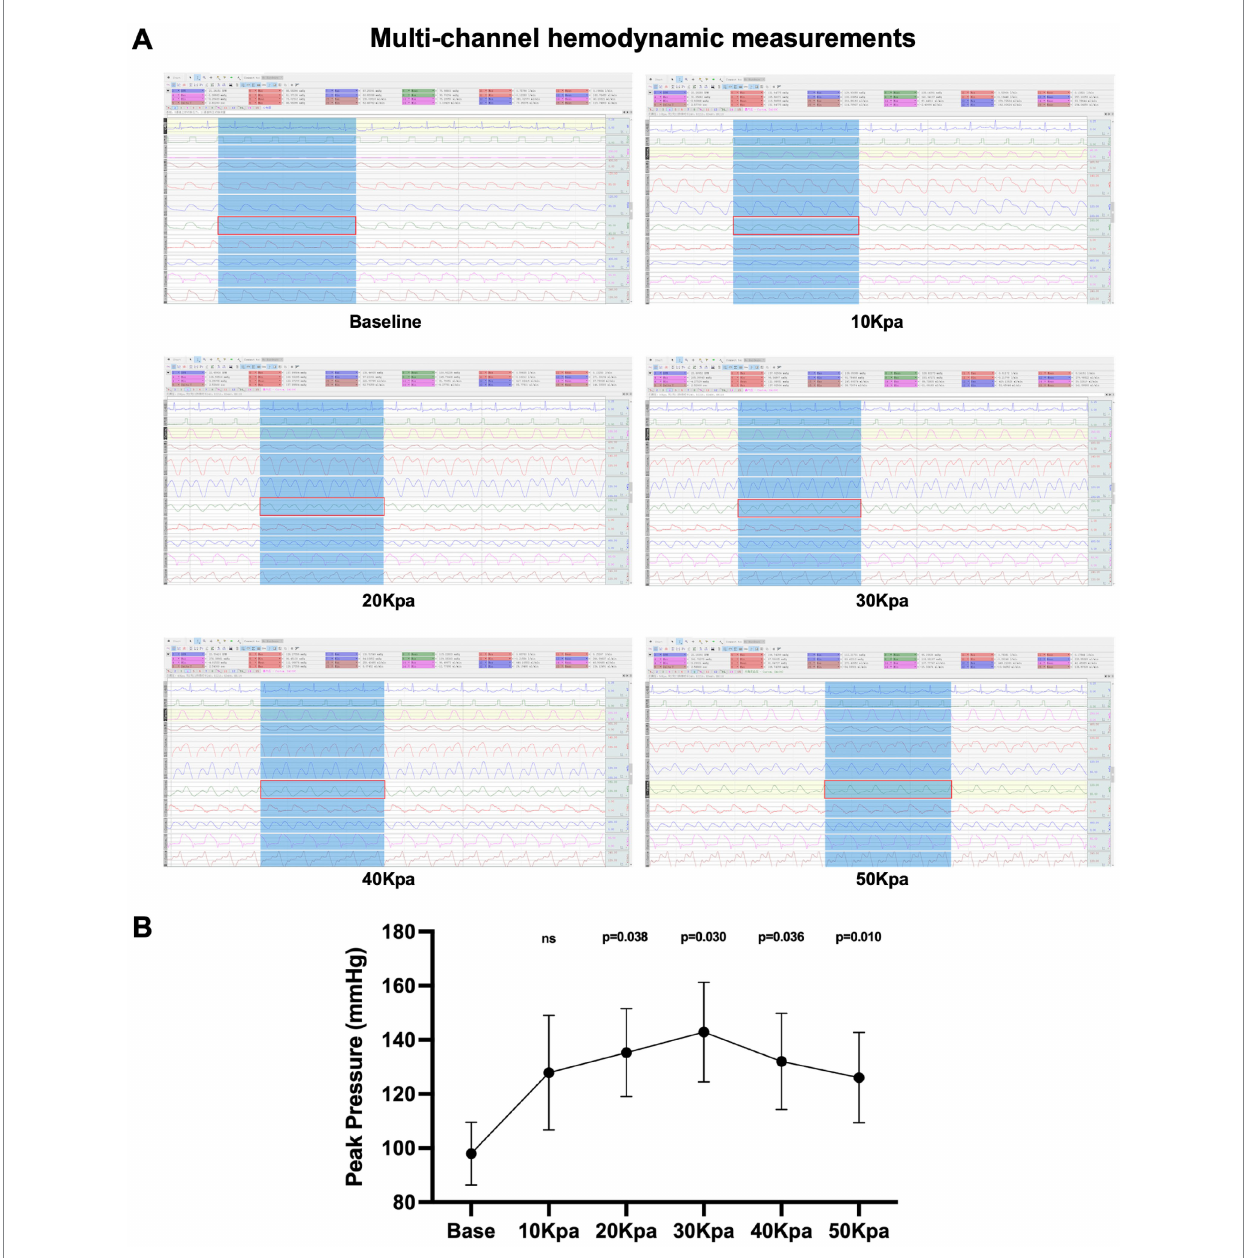
FIGURE 3 Multi-channel hydrodynamic measurements under EECP intervention. (A) Multi-channel hydrodynamic measurements of different counterpulsation pressures. The eighth channel (red rectangle) is the radial artery pressure. (B) Peak pressure of radial artery under different counterpulsation pressure. Data were expressed as means ± SD ( n = 3). Results were evaluated by Student’s t -test (each counterpulsation pressure with